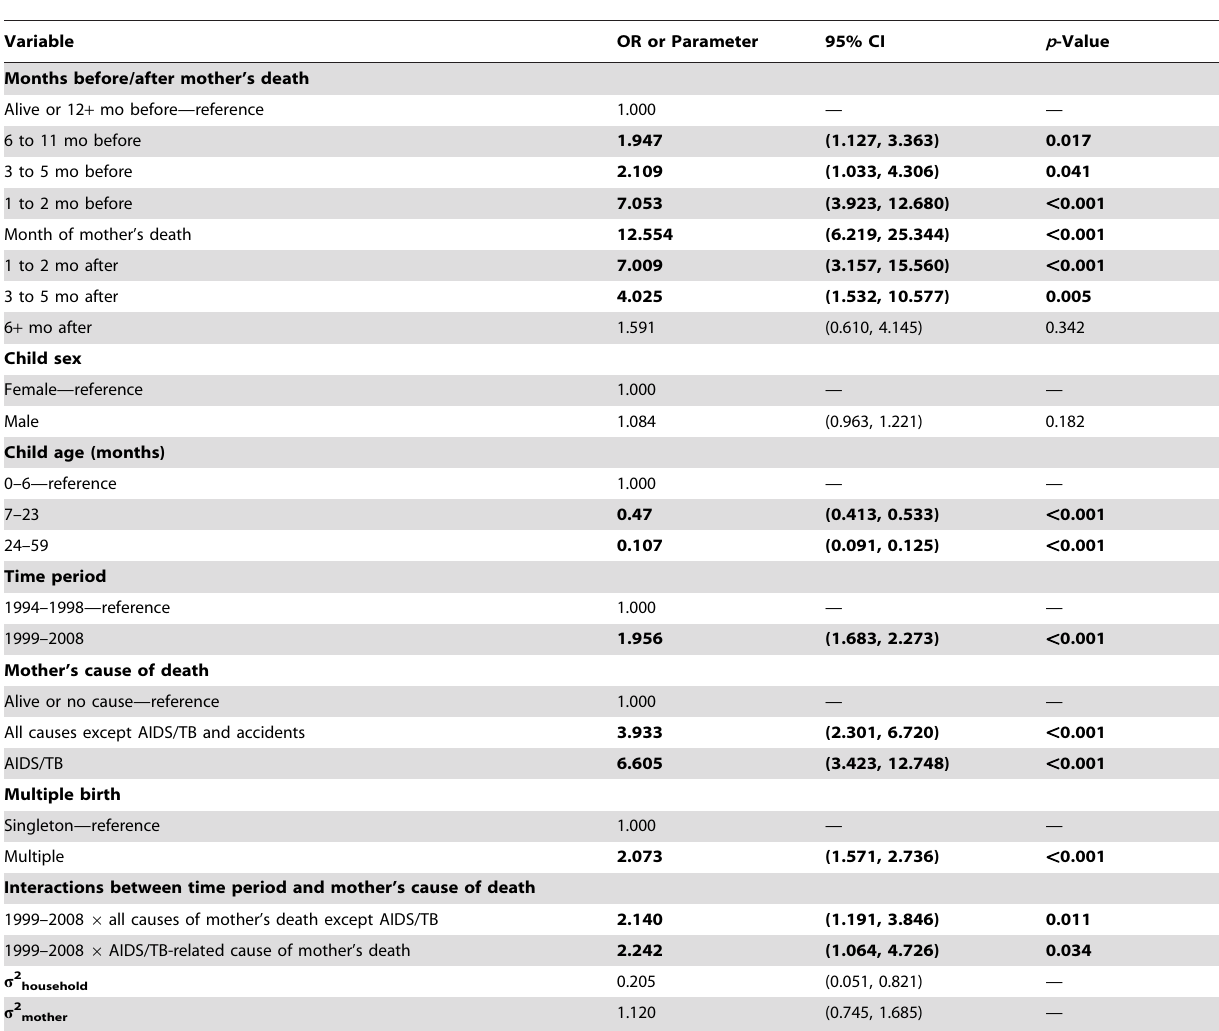
Table 2. Results of discrete time survival analysis of child death: odds ratios from multi-level logistic regression of monthly child deaths on months mother dead and controls, Agincourt, South Africa